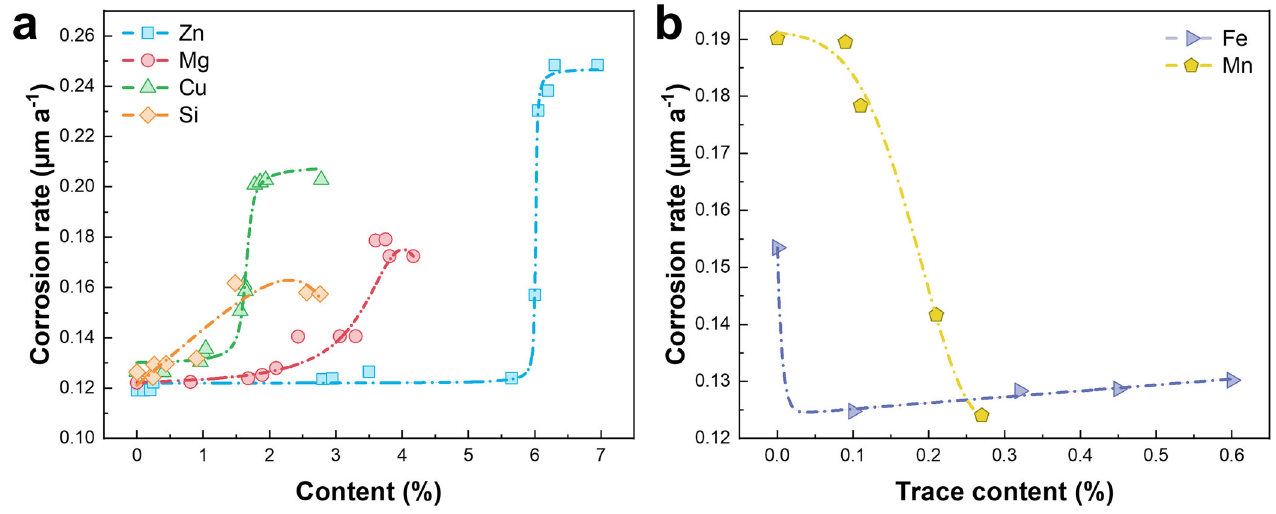
Fig. 4 Elaboration of element effect on corrosion rate. a Common elements. b Trace